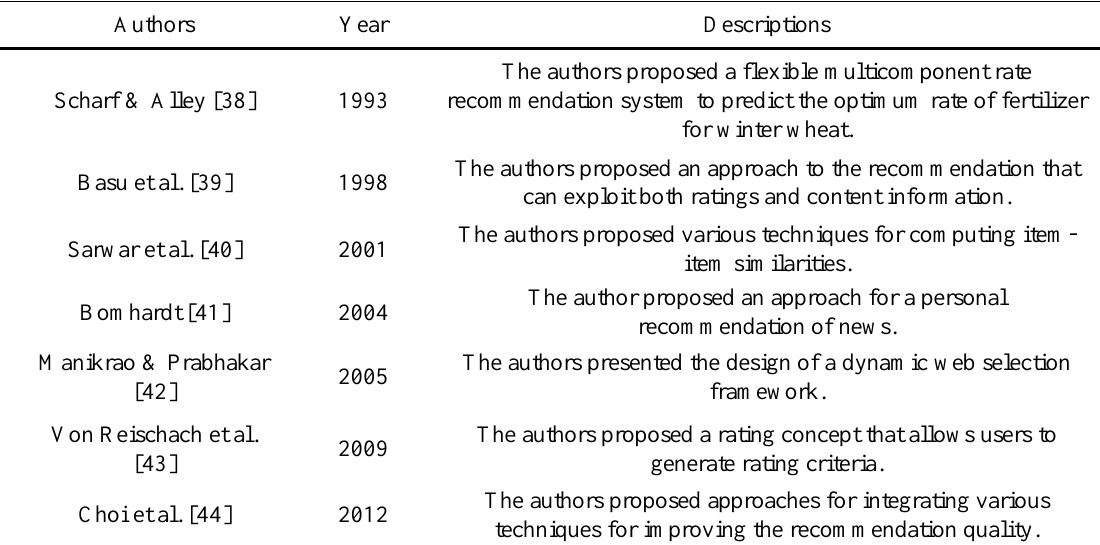
Table 1. Literature review of recommendation systems.